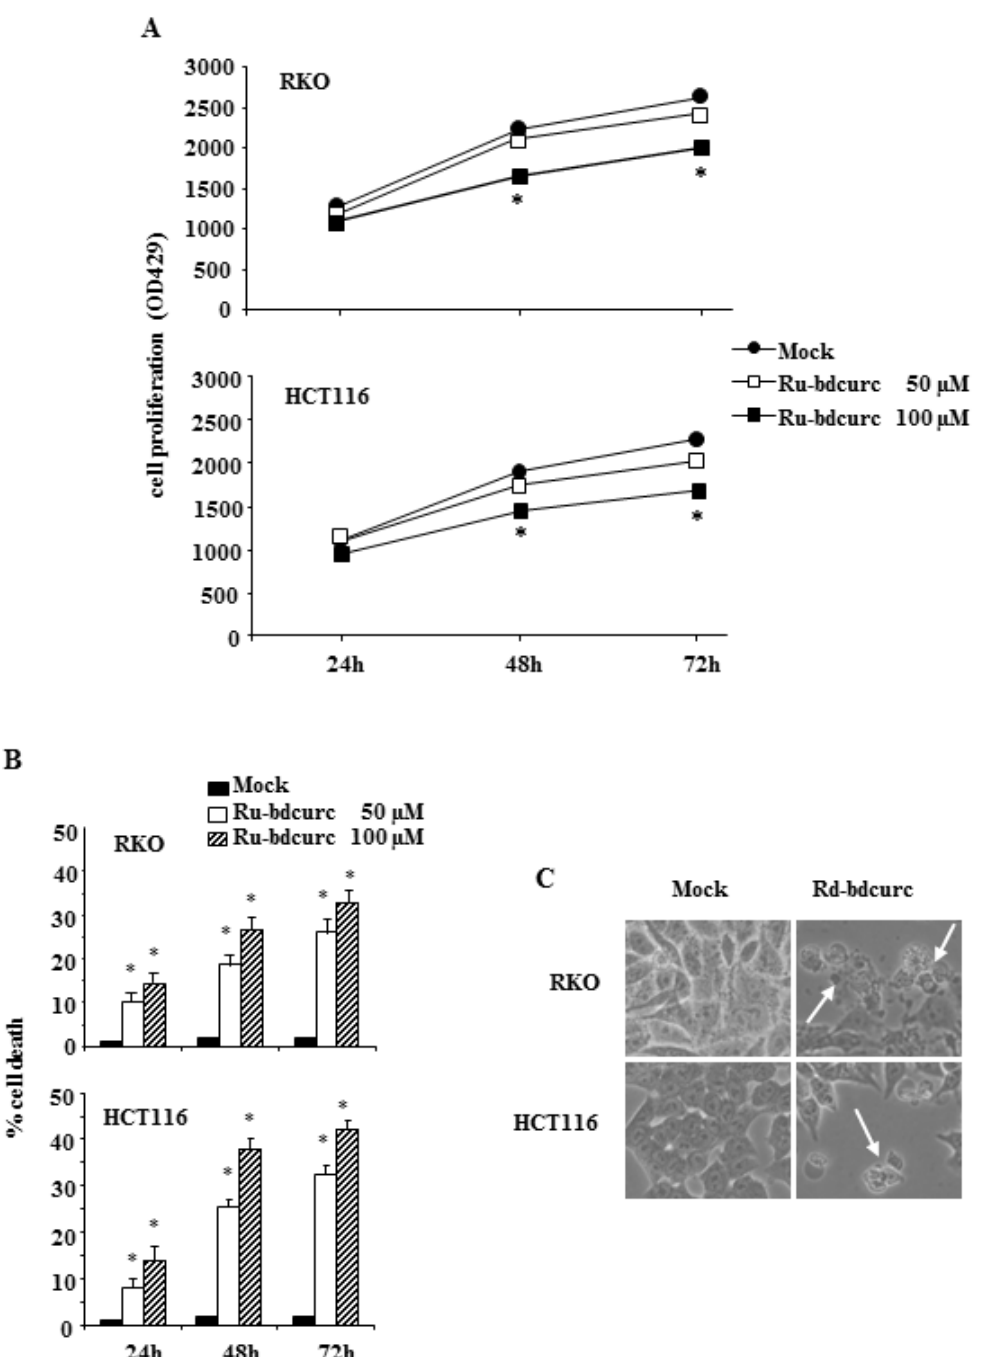
Figure 2. Dose-and time-dependent inhibition of colon cancer cells proliferation by Ru-bdcurc. ( A ) RKO and HCT116 colon cancer cells were left untreated or treated with different doses of Ru-bdcurc (50 and 100 µM) for 24, 48, and 72 h before cell proliferation was measured by XTT assay. ( B ) Cell viability of cells treated as in ( A ) was measured by Trypan blue exclusion assay and ( C ) live cell images were taken by light microscopy. * p ≤ 0.05. White arrows indicate dead cells.